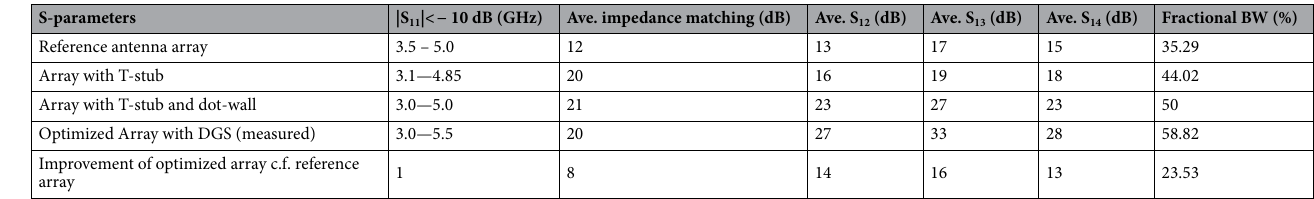
Table 2. S-Parameter comparison of the four antenna arrays.